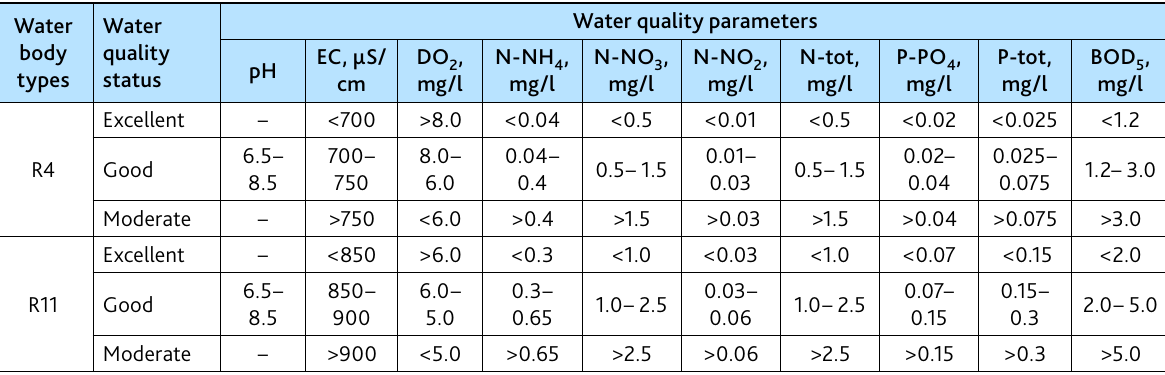
Table 1. Reference values of physicochemical parameters at different water body types as pointed out in Regulation H-4/2012 for characterization of the surface